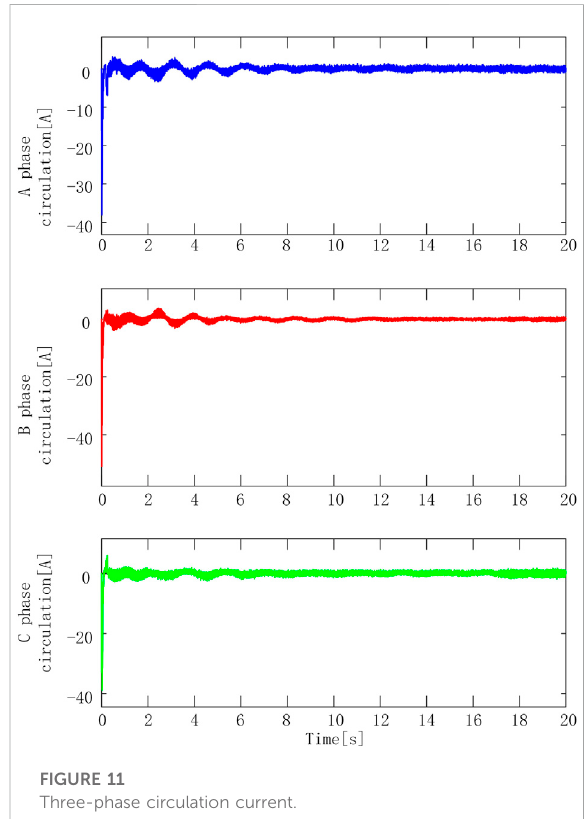
FIGURE 11 Three-phase circulation current.